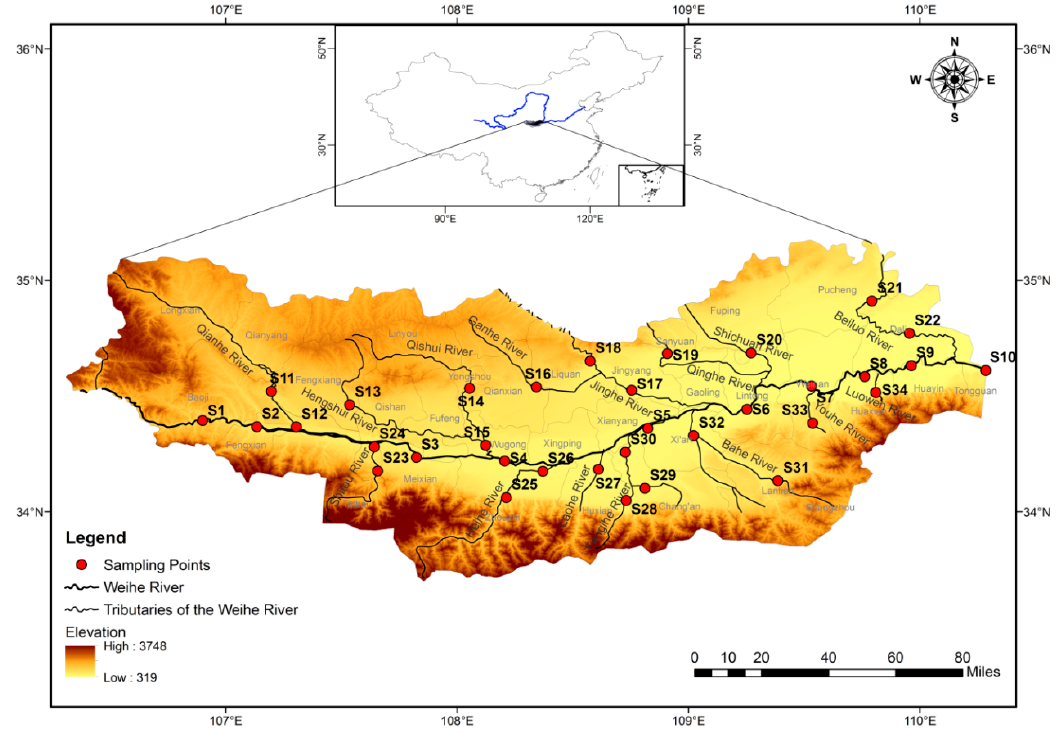
Figure 1. A schematic map showing the location of the study area and water sampling sites.